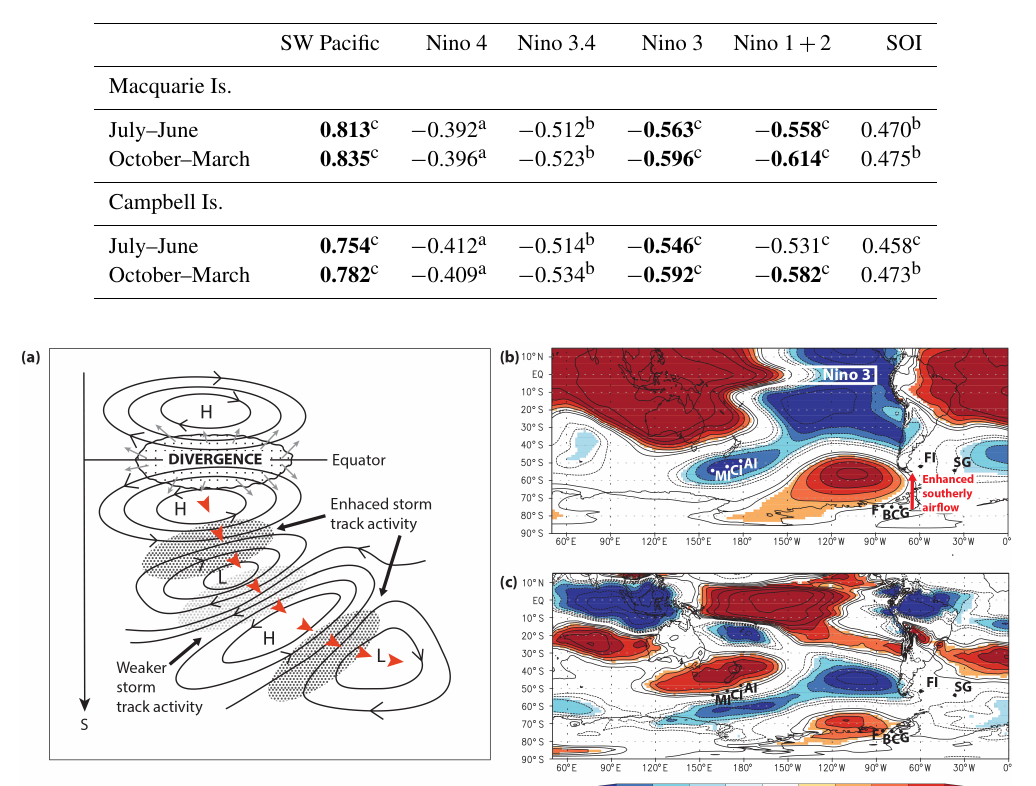
Table 1. Correlations and significance of relationship between subantarctic island air temperatures and measures of regional (50–60 ◦ S, 150–170 ◦ E) and equatorial Pacific sea surface temperature (SST) and atmospheric circulation. Regional and Nino temperature anomalies as calculated from HadISST (Rayner et al., 2003); the Southern Oscillation Index (SOI) as reported by Ropelewski and Jones (1987). Deseasonalised and detrended correlations derived for the period CE1979 to 2014. Significance indicated as follows: a p < 0 . 05, b p < 0 . 01, and c p < 0 . 001 (latter given in bold).